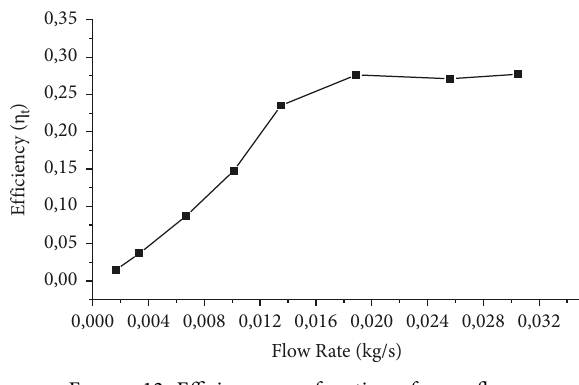
Figure 12: Efficiency as a function of mass flow.